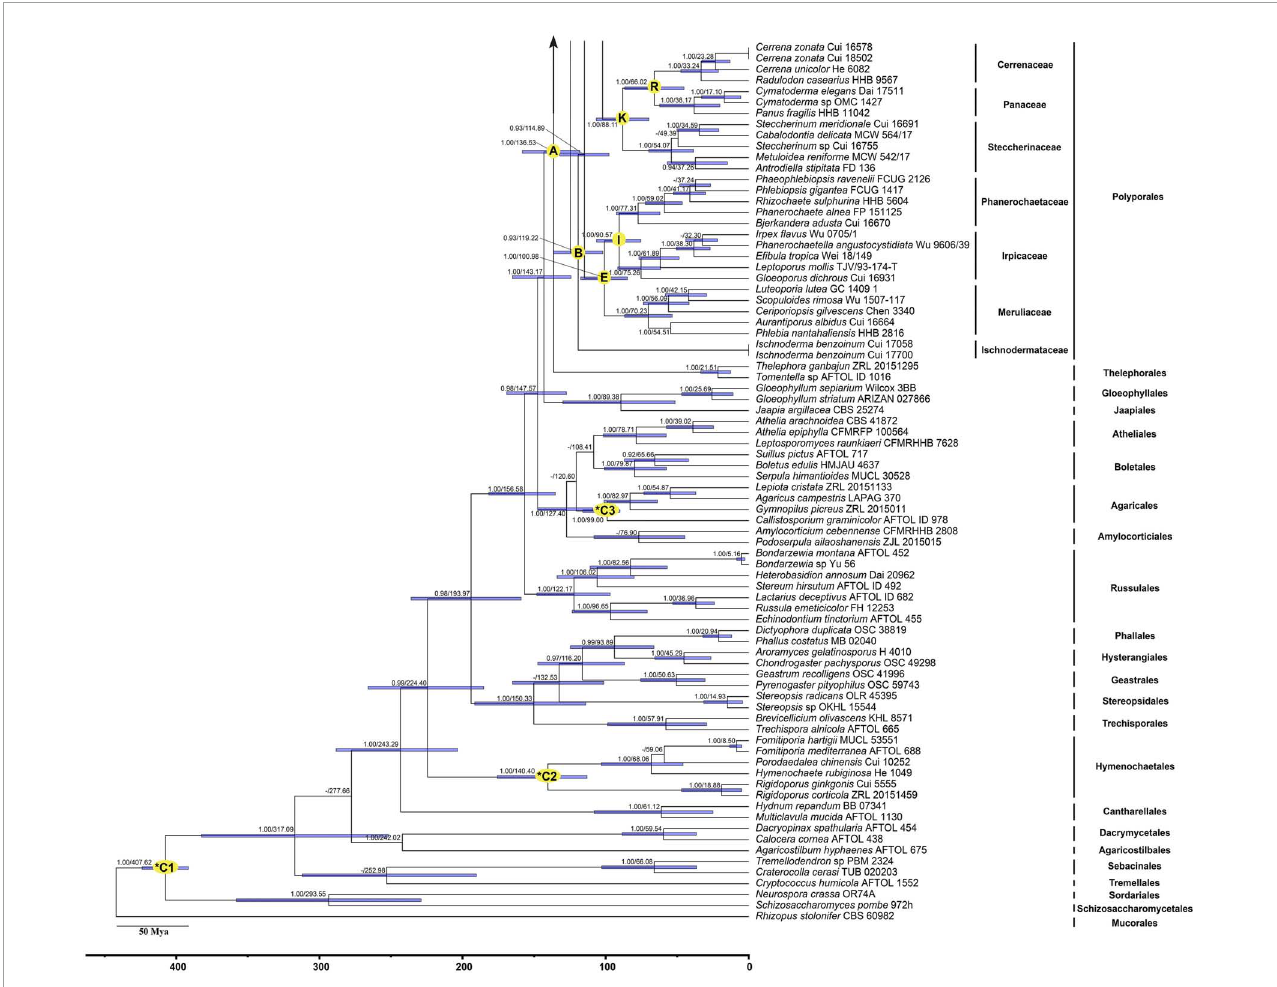
FIGURE3 Divergence time estimation of families within Polyporales from Bayesian evolutionary analysis sampling tree based on the combined sequence dataset of 5.8S + nLSU + RPB1 + RPB2 + TEF1. Posterior probabilities not less than 0.80 and the mean ages of each node are annotated. The 90% highest posterior densities of divergence time estimation are marked by horizontal